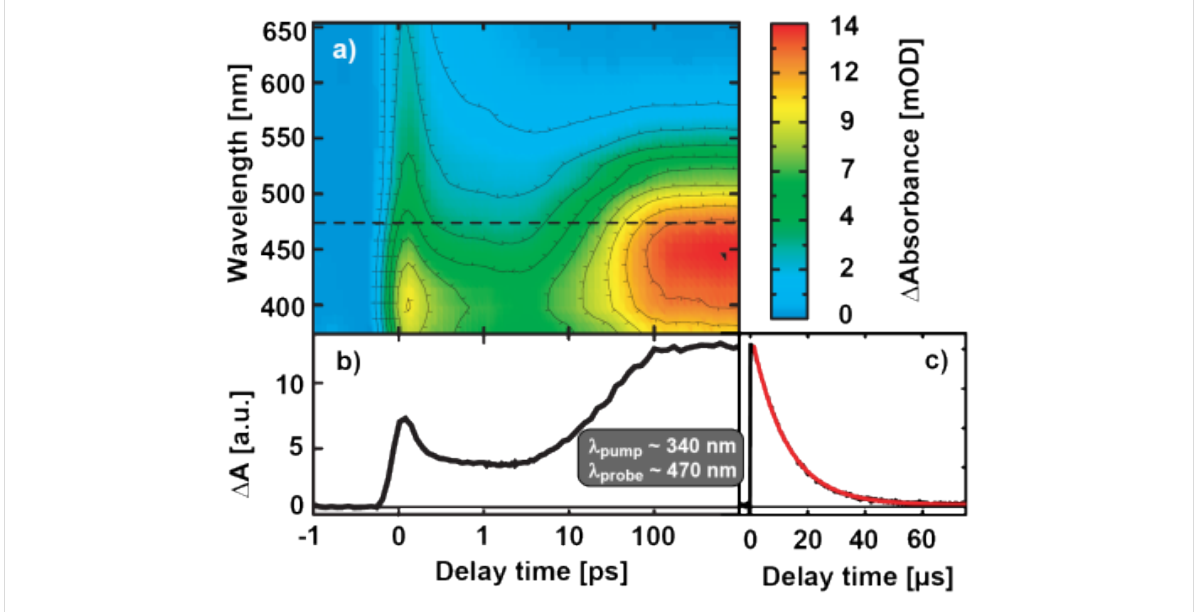
Figure 1: Data from time-resolved measurements of compound 5a . a) and b): Results from fs-pump-probe-spectroscopy. Please note the linear time- scale from −1 ps to 1 ps and the logarithmic scale thereafter. a) Two-dimensional overview plot of the transient absorbance changes in false colour coding. a.u. = arbitrary units. b) Temporal behaviour of the absorbance changes at a detection wavelength of 470 nm. c) Results from laser-flash photolysis. The transient was recorded at 470 nm (black) and is shown together with a single-exponential fit (red) yielding a decay time of 12 μs.